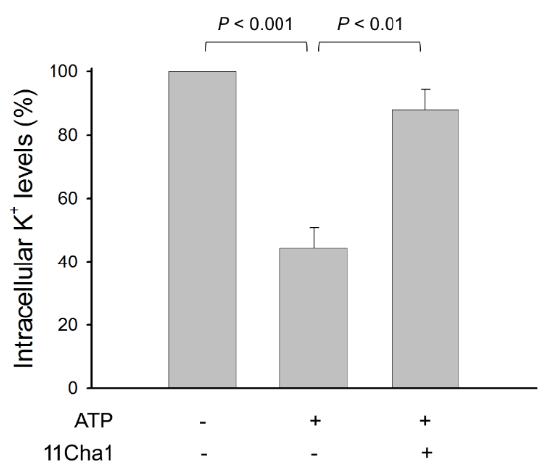
Figure 6. Effect of 11Cha1 on ATP-induced K + outflow from cells. THP-1 cells were seeded and differentiated by 50 nM PMA for 48 h and then primed with 1 μg/mL LPS for 4 h. The cells were pre-treated with or without 11Cha1 (30 µM) for 30 min and then treated with 5 mM ATP for another 30 min. After treatment, intracellular potassium content was determined using Potassium Assay Kit (MyBioSource, San Diego, CA, USA) according to manufacturer’s protocols. Data are expressed as mean ± SEM of five independent determinations. One-way ANOVA by Newman Keuls post hoc test is used. The analyses of P (AVOVA) indicates P < 0.001.